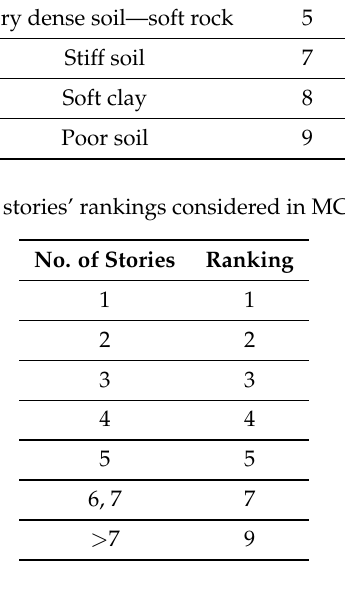
Table 10. ‘Building quality’ rankings considered in MCDM